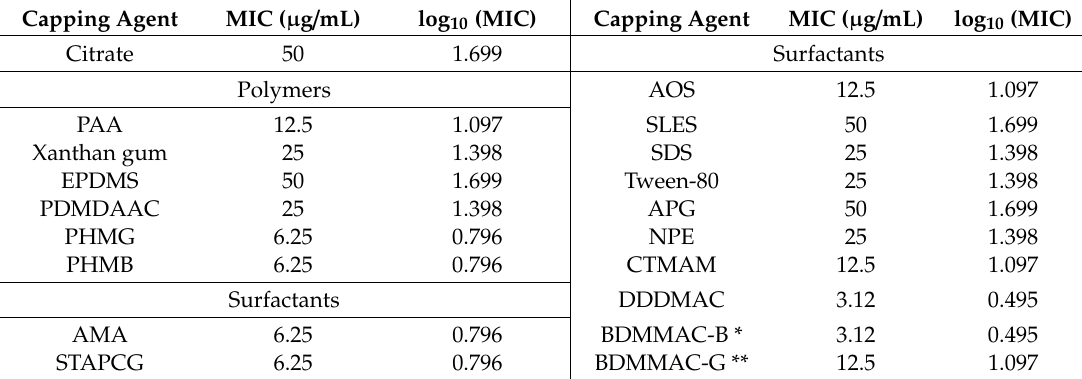
Table 3. Minimum inhibitory concentration (MIC) of silver NPs capped with di ff erent stabilizers introduced into the nutrient-infused medium towards S. cerevisiae cells; the nanosilver / capping agent ratio is given in Table